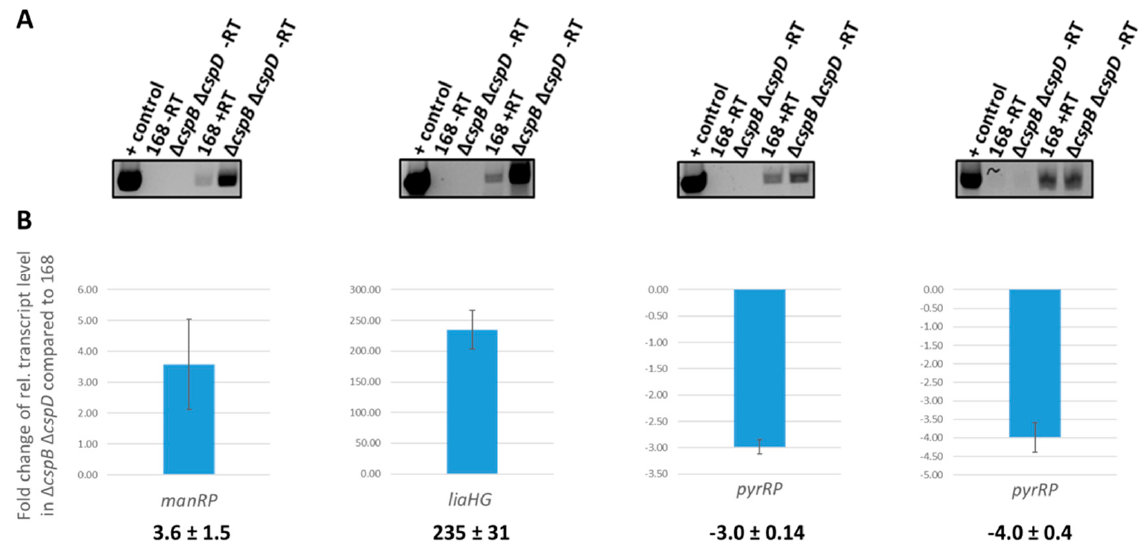
Figure 7. Transcriptional read-through in 168 and the ∆ cspB ∆ cspD mutant. ( A ) Qualitative PCR on read-through transcripts. Total RNA was extracted from 168 and GP1971. cDNA was synthesized and served as a template in a PCR with primers annealing up- and downstream of the terminators between manR-manP , liaH-liaG , pyrR-pyrP-pyrB . ‘+ control’: standard PCR using chromosomal DNA of B. subtilis 168 as the template, ‘-RT’: control sample without reverse transcriptase, ‘+RT’: sample with reverse transcriptase. ( B ) Fold changes in the expression of read-through transcripts in a ∆ cspB ∆ cspD (GP1971) mutant relative to levels in the wild-type strain (168) are shown. RNA was purified from each strain, and quantitative RT-PCR was performed using primer sets amplifying up- and downstream of the terminators in the indicated intergenic regions. Shown values represent the mean of three biological replicates. Errors bars indicate the standard deviations.